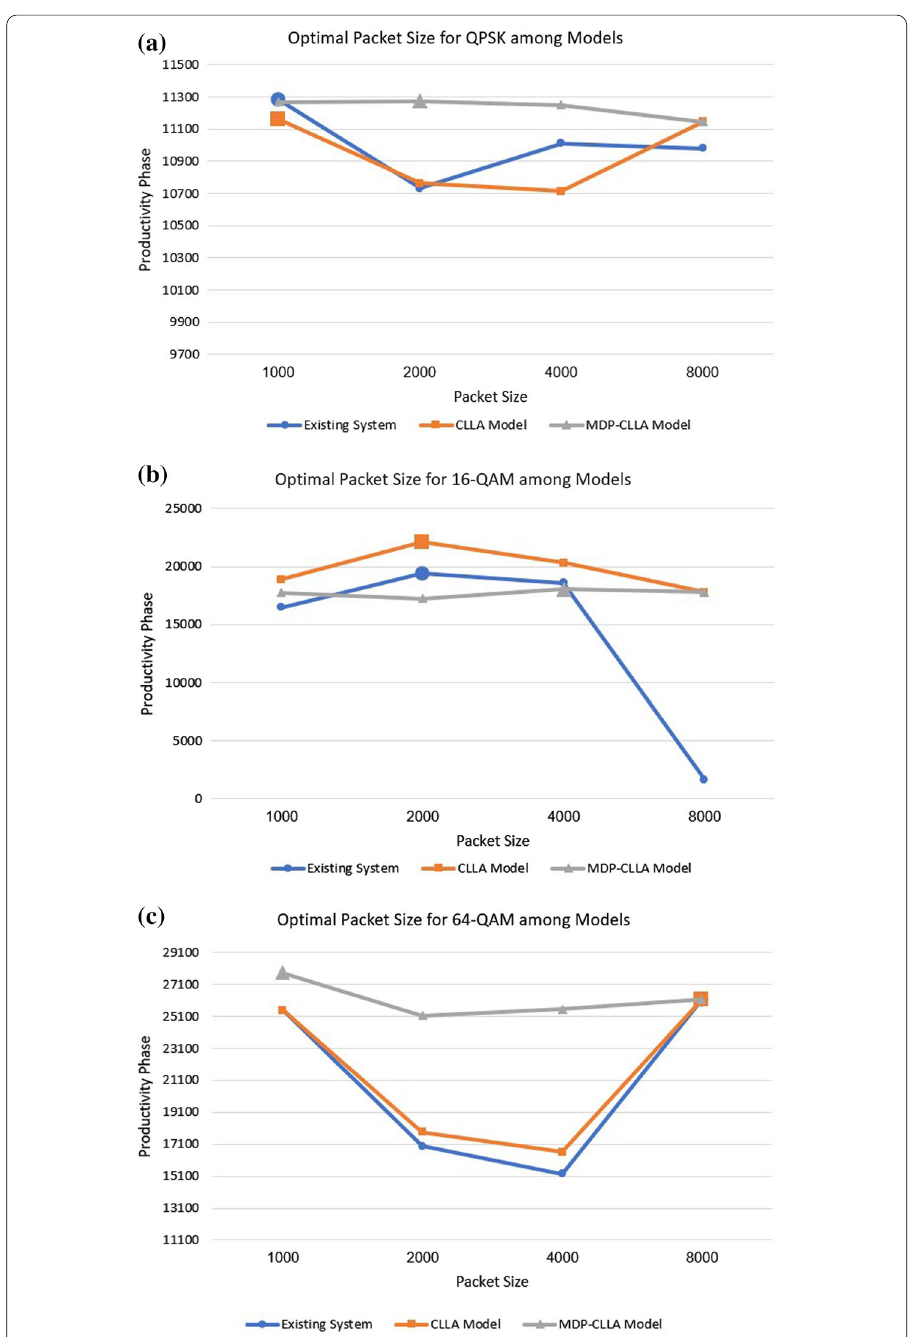
Fig. 14 a QPSK, b 16‑QAM c , 64‑QAM ( a – c ) optimal packet size evaluation for each modulation among